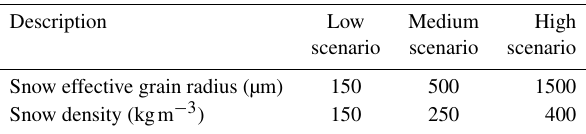
Table 1. Snow effective grain sizes and snow density used for the albedo calculation with the SNICAR